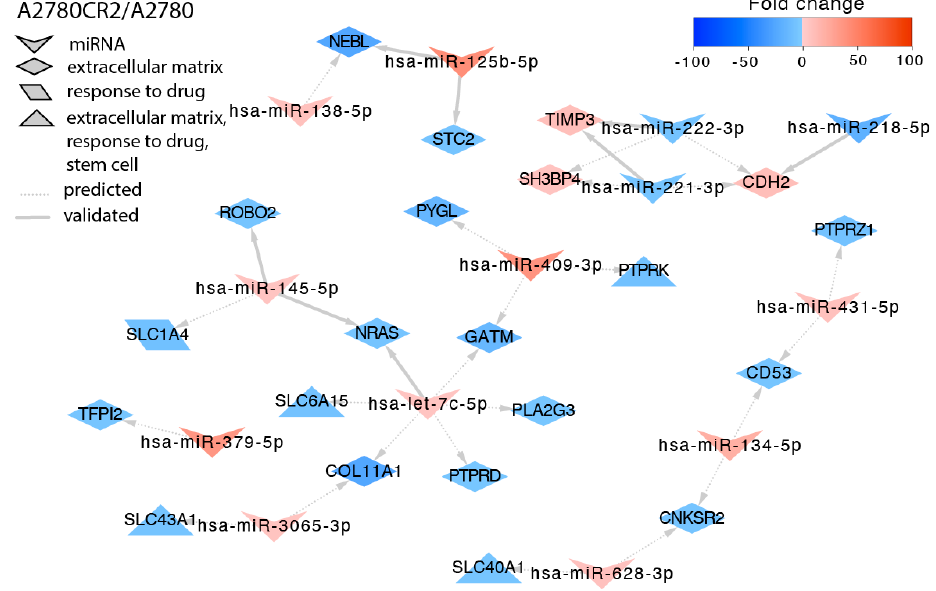
Figure 4. Regulation of selected target genes by miRNAs in the A2780CR2 cell line.